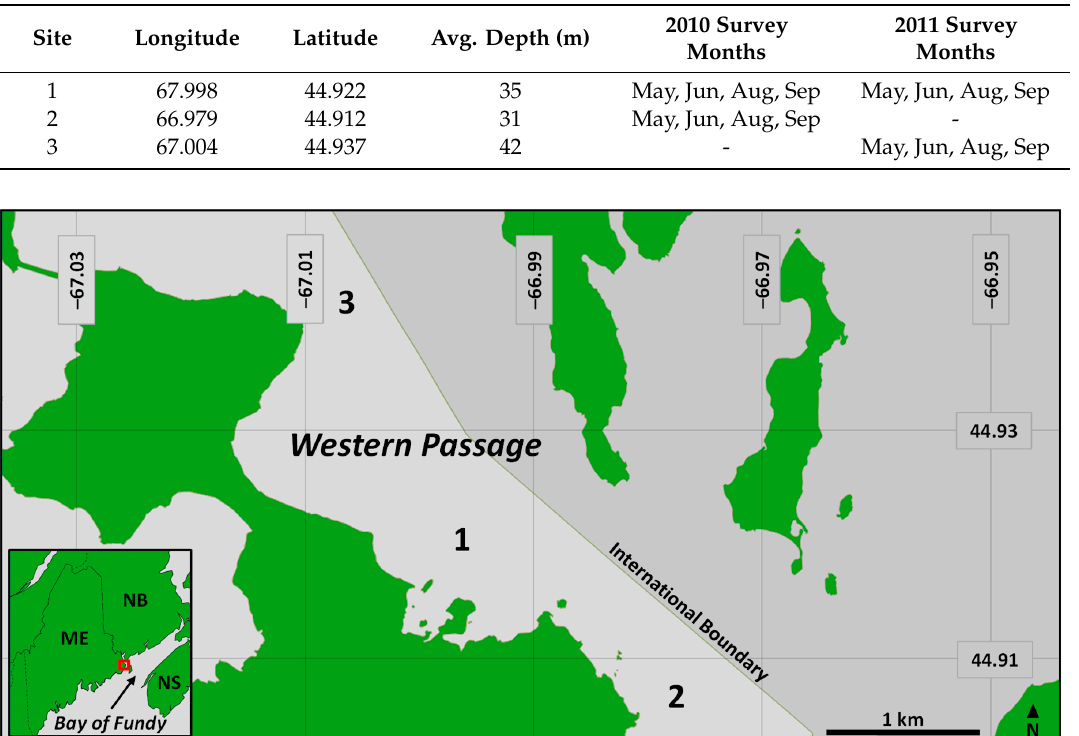
Table1. Characteristicsofeachsamplingsiteandmonthsof24-hhydroacousticsurveys. Depthvariation is due to tidal stage, bathymetry, and vessel movement.